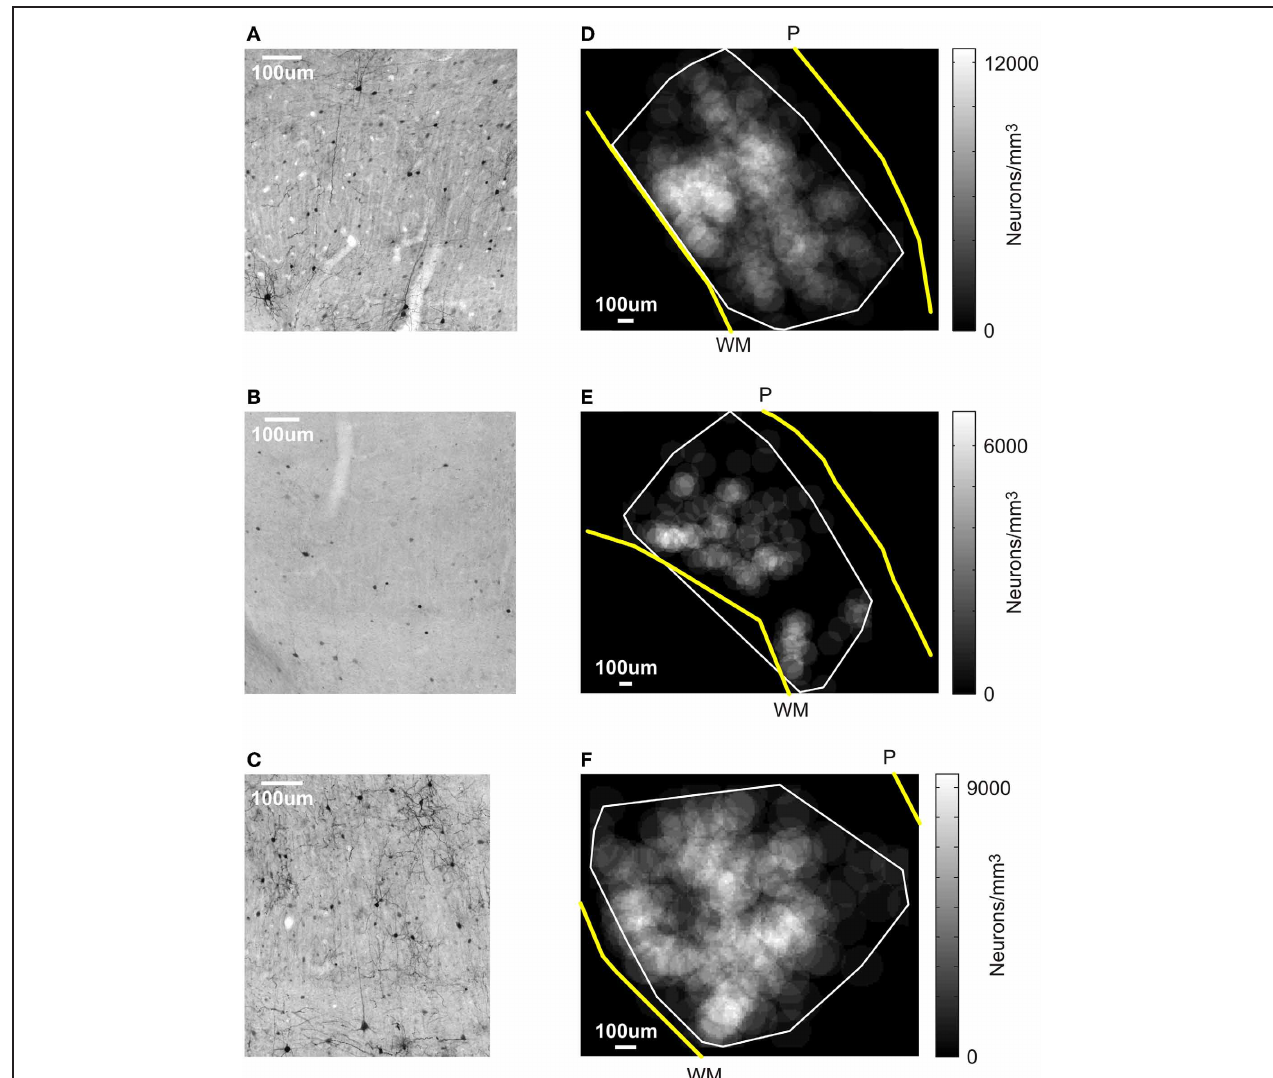
FIGURE 3 | Results of the post-mortem histology. (A – C) V1 sections stained for GFP. Cells stained black are GFP-positive, which is co-localized with AlstR expression. Scale bar: 100 μ m. (A) Tissue from monkey W. (B) Section of V1 at the first virus injection site in monkey V. (C) V1 section at the second injection site in monkey V. (D – F) Spatial profile of labeling density for an example section for each injection site. The gray scale level in this